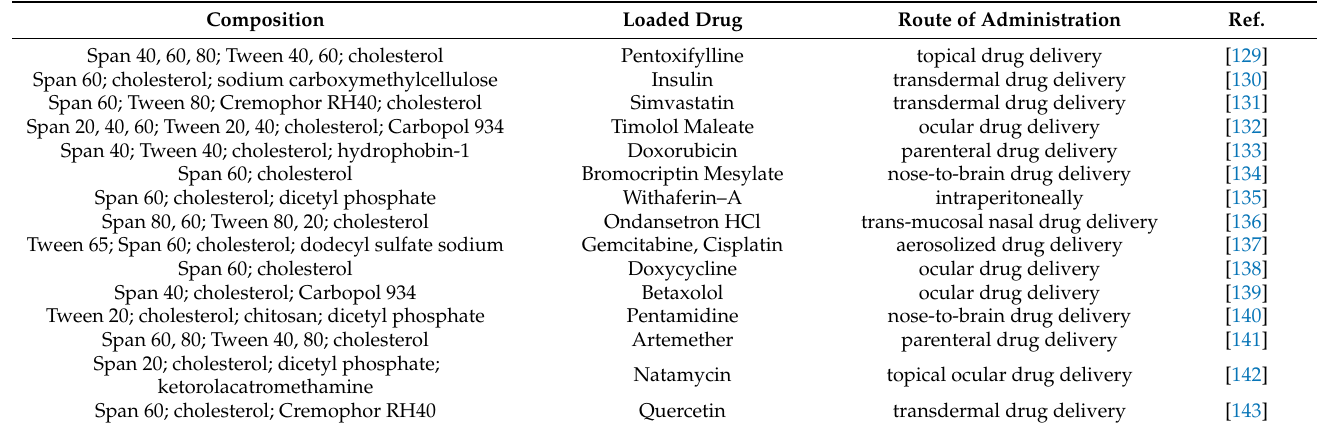
Table 1. Niosomes as vehicles for drug